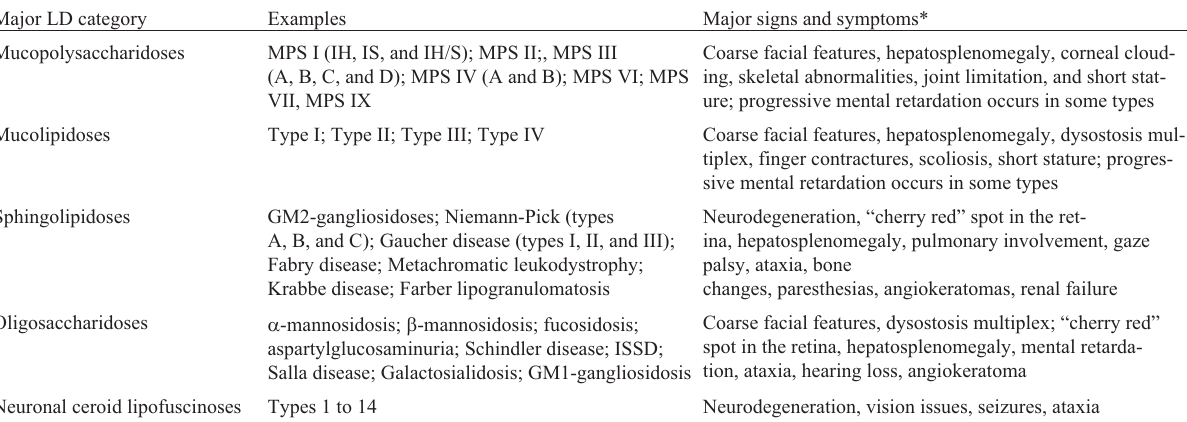
Table 2 - Major signs and symptoms of